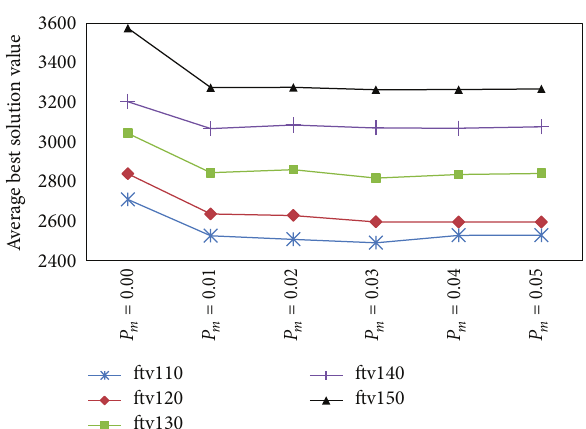
Figure 5: Average best solution values on five asymmetric TSPLIB instances using six mutation